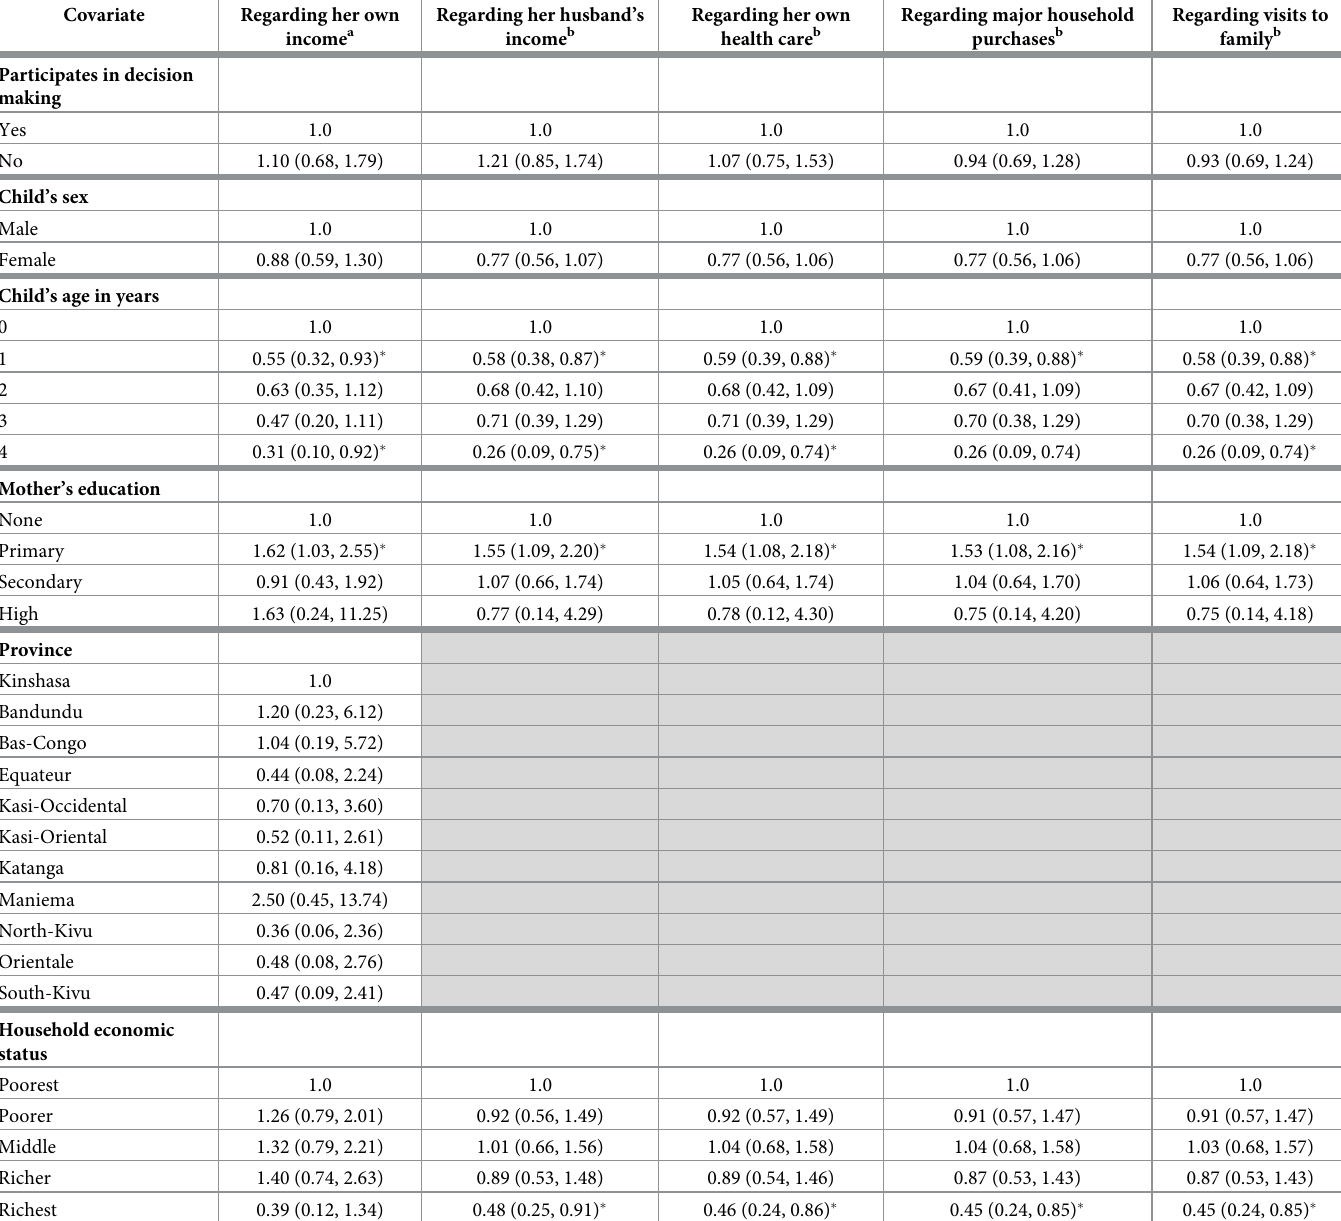
Table 4. Adjusted odds ratios for the outcome of